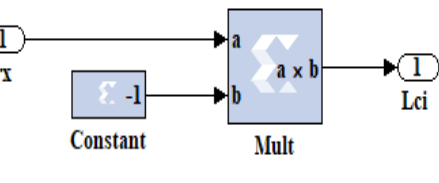
Fig. 8. Initialization process ( ).